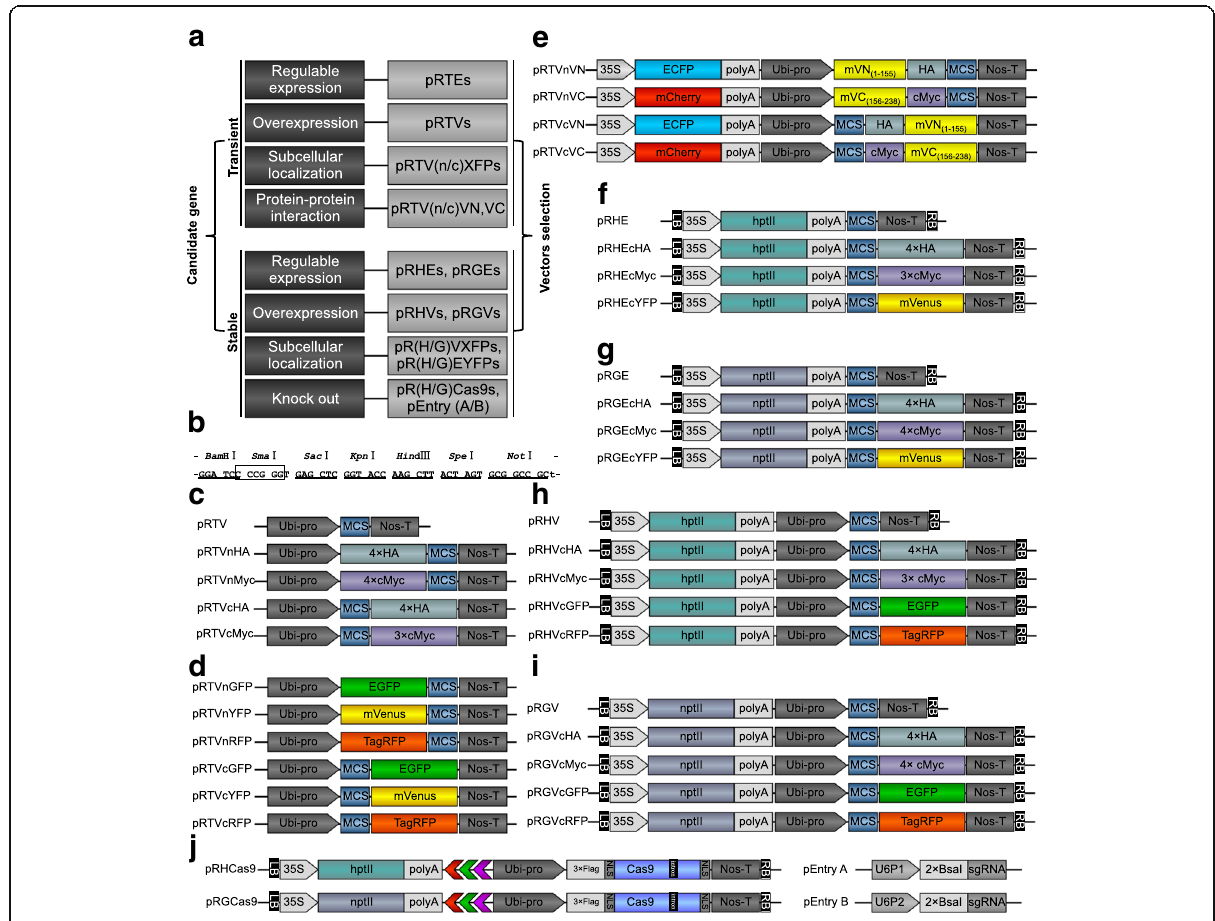
Fig. 1 Schematic diagrams of the vectors. a Type and naming system of the 42 vectors. b The sequence and restriction enzymes in the multiple cloning site (MCS). c - e Vectors for rice transient overexpression. c pRTVs vectors with or without multiple N-/C- terminal HA tags or cMyc tags. d pRTVs vectors with N-/C- terminal fusion EGFP, mVenus, or TagRFP for subcellular localization in protoplasts. e Vectors for BiFC assays. mVN (1 – 155) and mVC (156 – 238) are the N and C terminal of mVenus, respectively. f - j Binary vectors for Agrobacterium -mediated transformation experiments. f and g , Vectors without the Ubi promoter for rice stable expression with hygromycin or G418 selection marker, respectively. h and i , Vectors for rice stable overexpression with hygromycin or G418 selection marker, respectively. j CRISPR/Cas9 vectors with hygromycin or G418 selection marker. hptII , the hygromycin selection marker gene; nptII , the G418 or kanamycin selection marker gene; LB, T-DNA left border; RB, T-DNA right border; NLS, nuclear localization signal; intron, second intron (IV2) of the potato gene